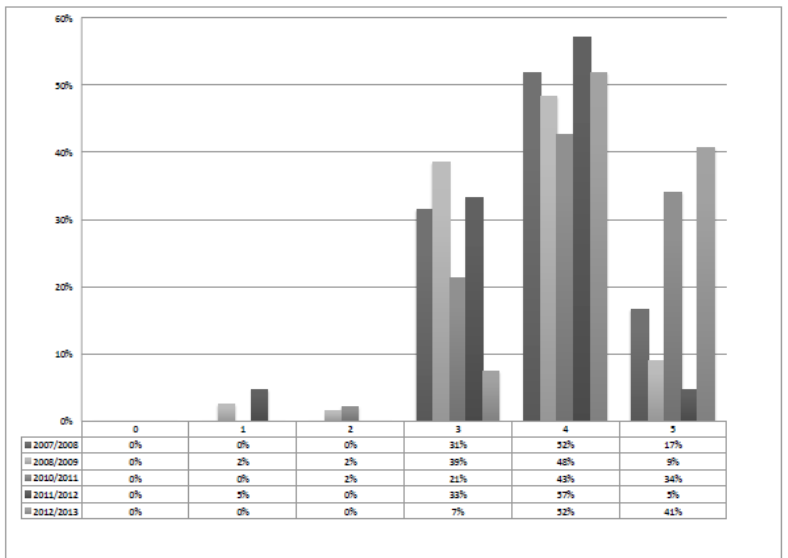
Figure 3. Your knowledge of Java programming language (syntax, arrays, lists,